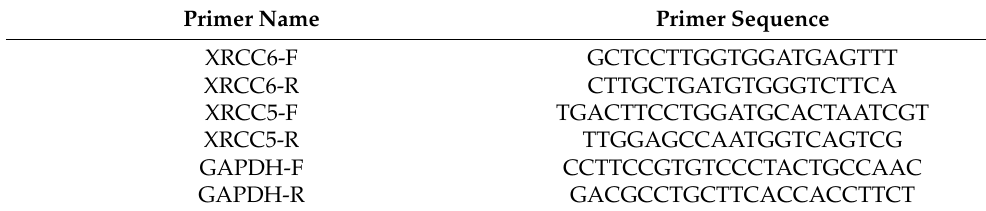
Table 1. Primers used in this